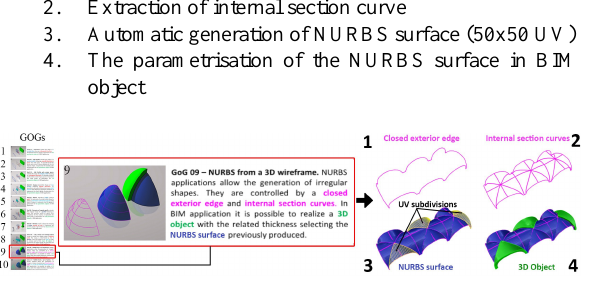
Figure 3. GOG 9: Automatic extraction of proper geometric primitives (1-2) for the generation of the NURBS model (3) and the subsequent automatic generation of complex Scan-to-BIM object (4).